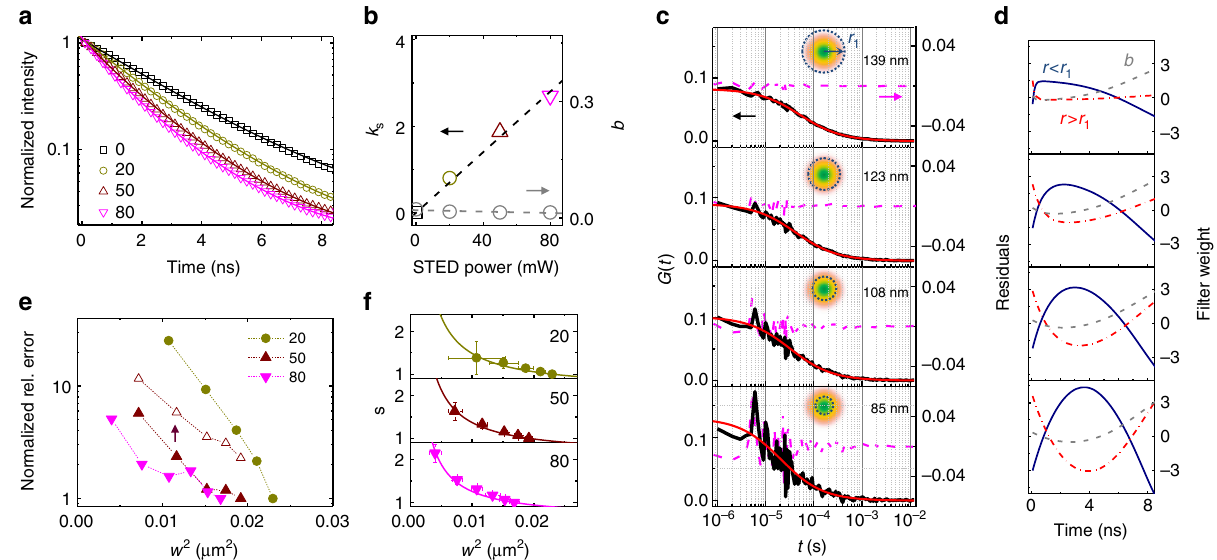
Fig. 2 SPLIT-FLCS of EGFP in solution. a Experimental STED decays of EGFP in PBS for different levels of STED intensity. Numbers indicate STED beam power in mW (measured at the back aperture of the objective lens). The solid lines represent a fi t of the data to the Eq. (2). Value of τ recovered from the confocal measurement is τ EGFP = 2.6 ns. b Values of the parameters k s and b recovered from the fi t shown in a . The increase of k s vs. STED power indicates an increase of the spatial variations of lifetime within the PSF. c Filtered ACFs of EGFP in PBS obtained at a STED power of 50 mW for different values of the parameter r 1 ( r 1 = 11 w 0 , 2 w 0 , w 0 , 0.5 w 0 , respectively, from top to bottom ). Each of the ACFs is obtained from a FLCS-based separation into three components d and is associated to the calculated decay corresponding to the radial region r < r 1 . Solid red lines are a fi t of the data to Eq. (15) and the numbers indicate the recovered lateral size w of the effective observation volume. Residuals are shown on the right axis ( purple dashed line ). d Filter weighting functions corresponding to the temporal signatures of the fl uorophores located at distance r < r 1 ( solid blue line ), the fl uorophores located at distance r > r 1 ( red dash-dot line ), and the fraction b of uncorrelated background ( gray dashed line ), respectively. e Normalized relative error associated to the values of w 2 recovered from SPLIT-FLCS analysis of EGFP at different STED intensity levels (STED beam power indicated in mW). The increase in relative error when the measurement time is reduced to t acq = 20 s is reported only for the STED power of 50 mW ( open triangles ). f Calibration of the effective volume shape factor s at different STED intensity levels (mean ± s.d.). The solid lines are a fi t of the data to Eq. (22). Values of ξ z recovered from the fi t are